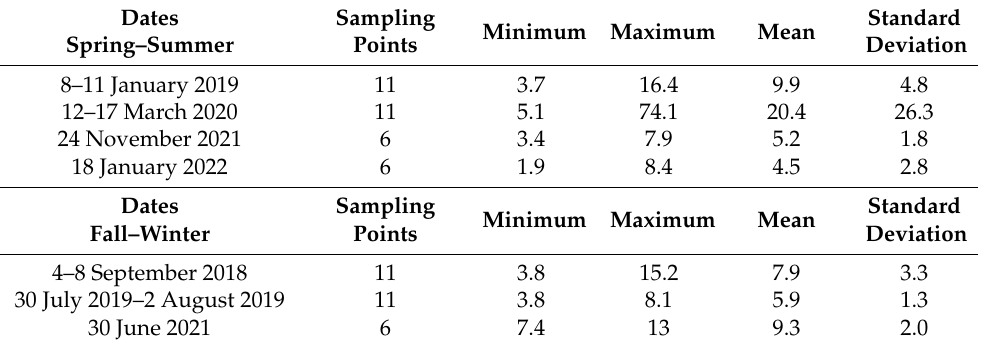
Table 1. Sampling dates and statistical summary of in situ Chl-a in the Lanalhue Lake. The concen- trations are in units of µ g L − 1 .